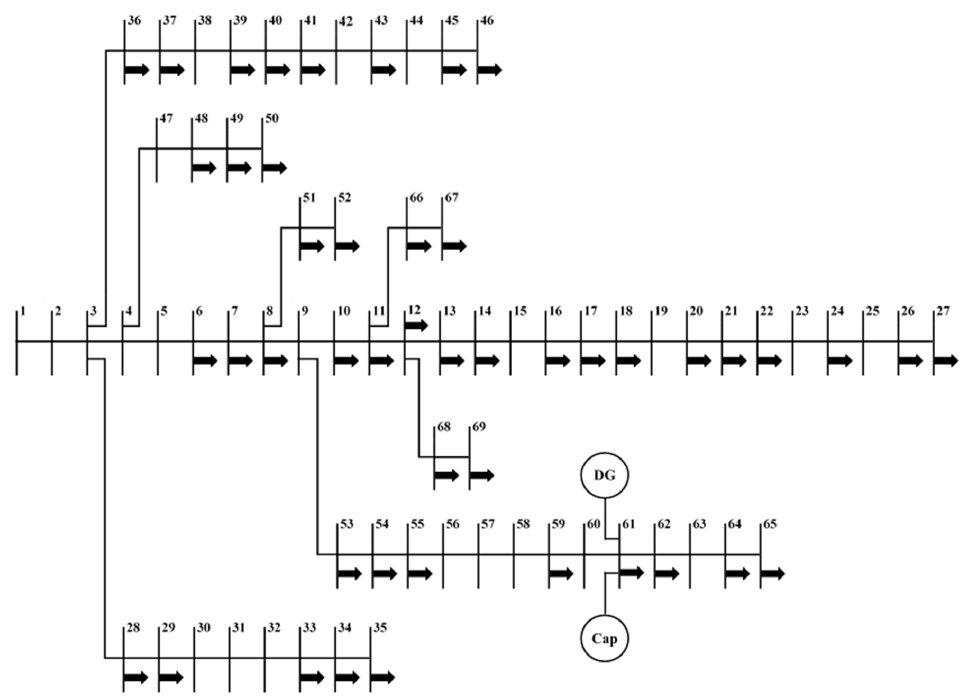
Figure 10. The 69-bus autonomous distribution network with installed distributed sources. Table 4. Results for the 69-bus autonomous distribution network.